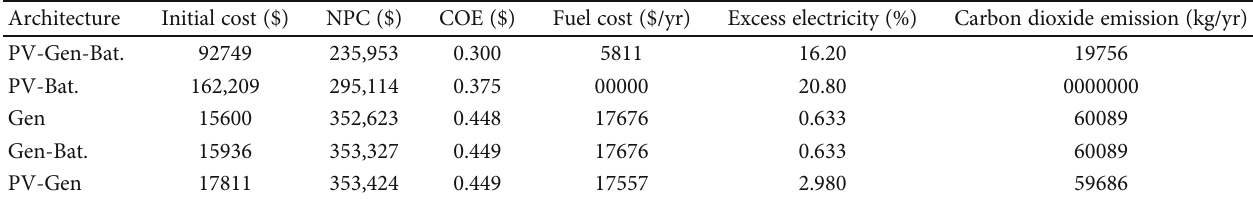
Table 5: Di ff erent architectures of energy sources and their performance for the secondary scenario.